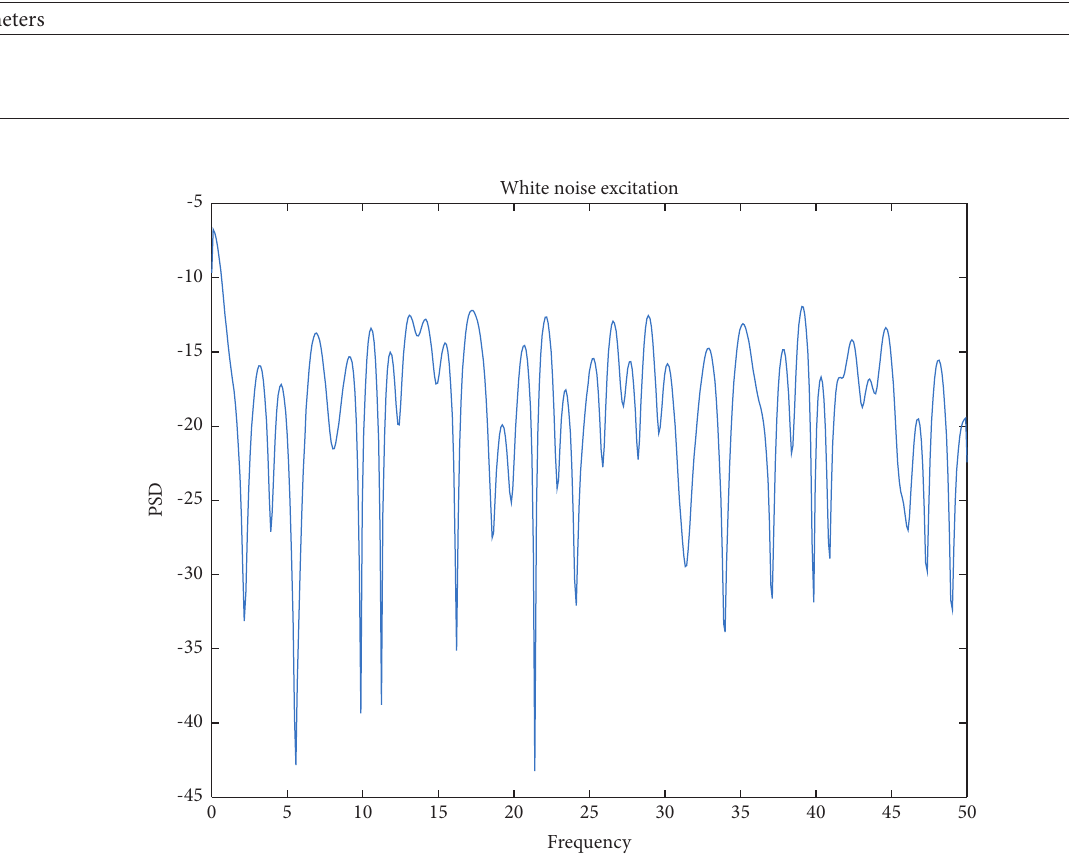
Table 4: Main design parameters of the PID controller.